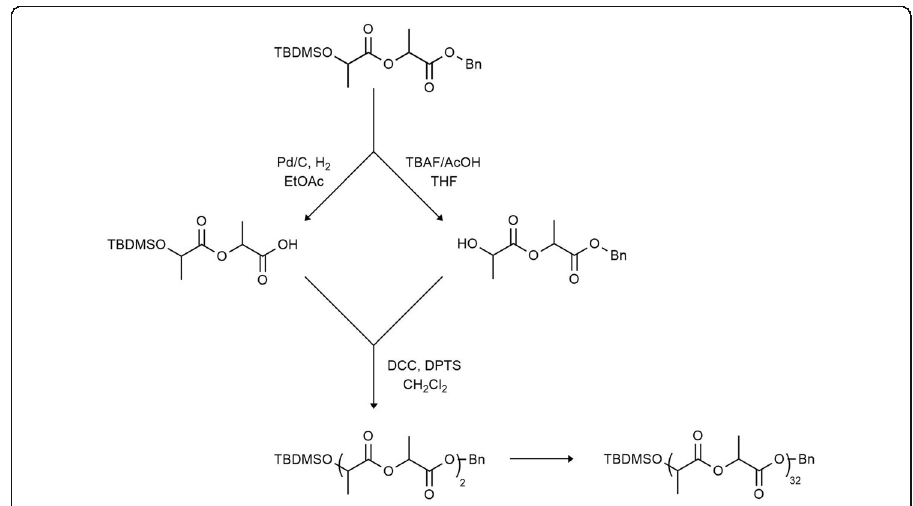
Fig. 5 The iterative method for oligolactide synthesis